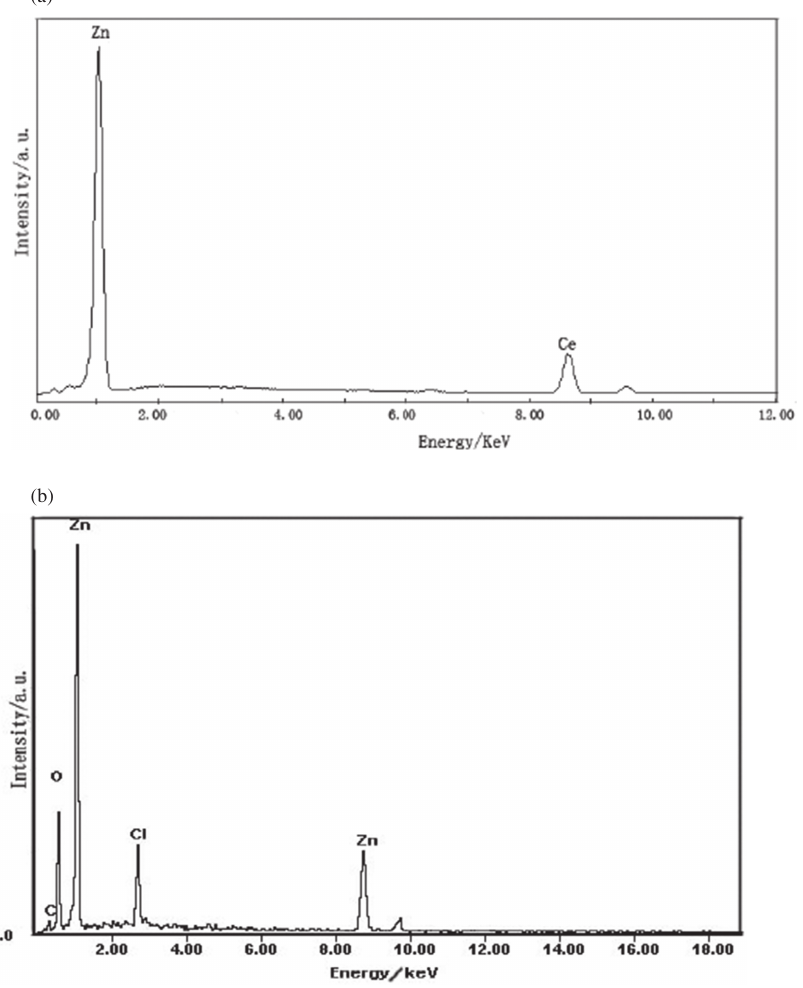
Figure 4: (a) The EDS energy spectrum of the cerium conversion coating of the zinc coating and (b) The EDS energy spectrum of the corrosion products of the cerium conversion coating in a 5% NaCl solution.